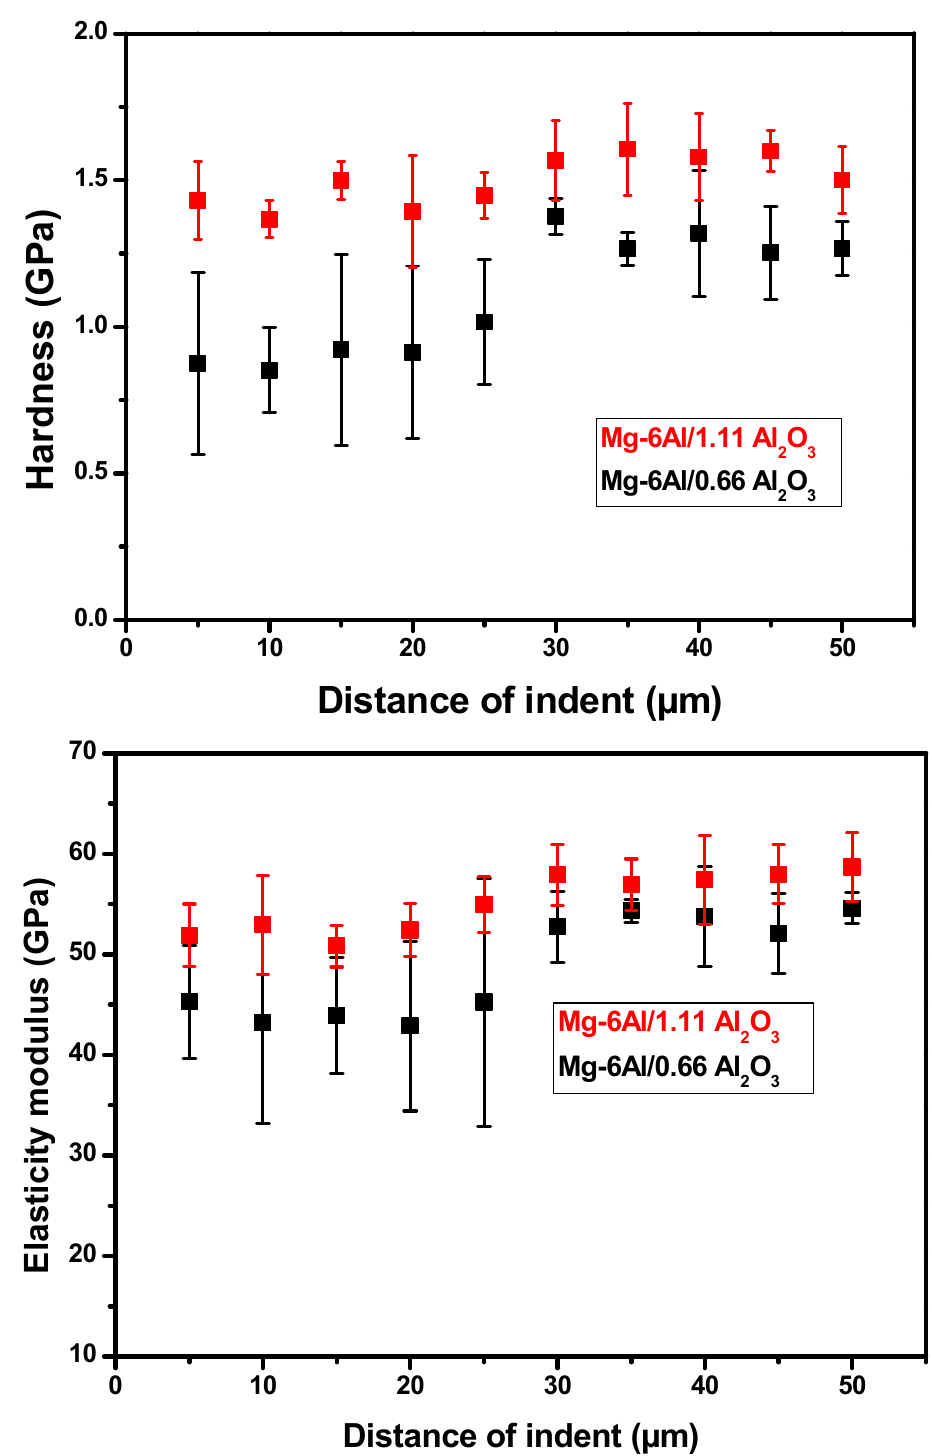
Figure 9. Variation in hardness and elastic modulus along the depth from the machined surface of both materials.